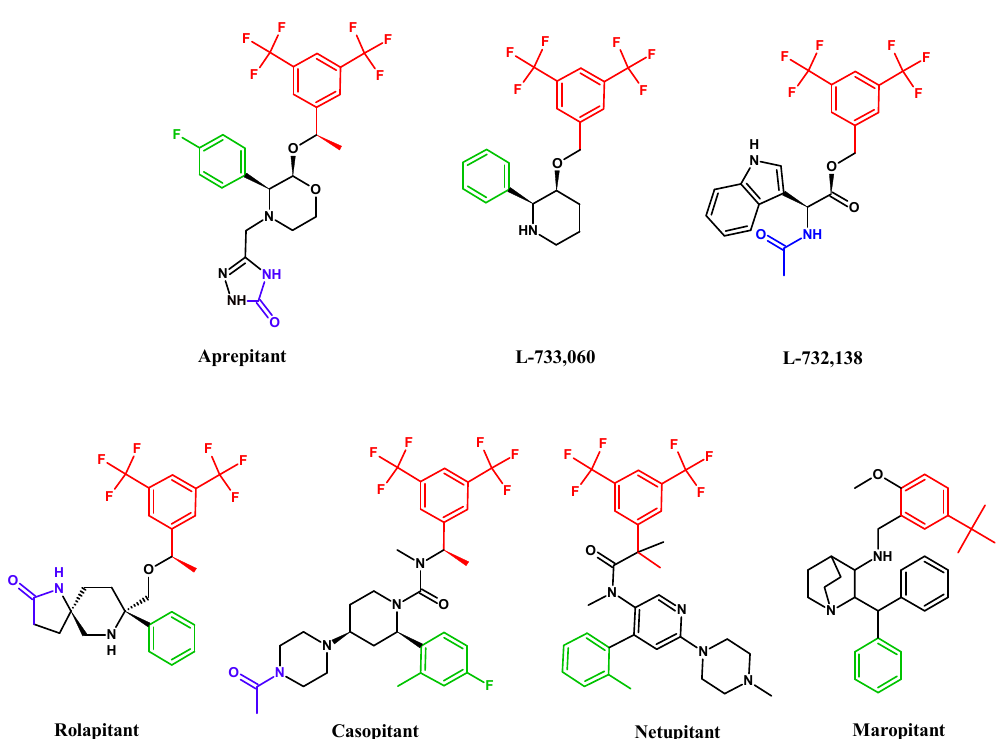
Figure 3. Colour visualisation of structure differences and similarities in the group of most antitumour evaluated NK1R antagonists (aprepitant, L-733,060 and L-732,138) and in group of CINV indicated NK1R antagonists (aprepitant, rolapinant, casopitant, netupitant and maropitant); the last presented, maropitant, despite the biggest structural distinction, showed high affinity to NK1R and sufficient clinical efficacy.